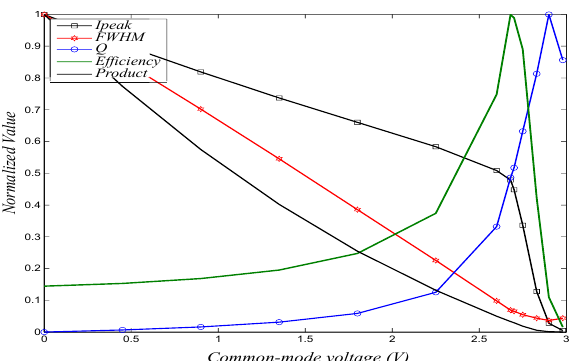
Figure 14. The power effectiveness and consumption is depending on the common-mode voltage of the input signals. The circuit is most effective regarding the power consumption when the common-mode is close to Vdd = 3.2